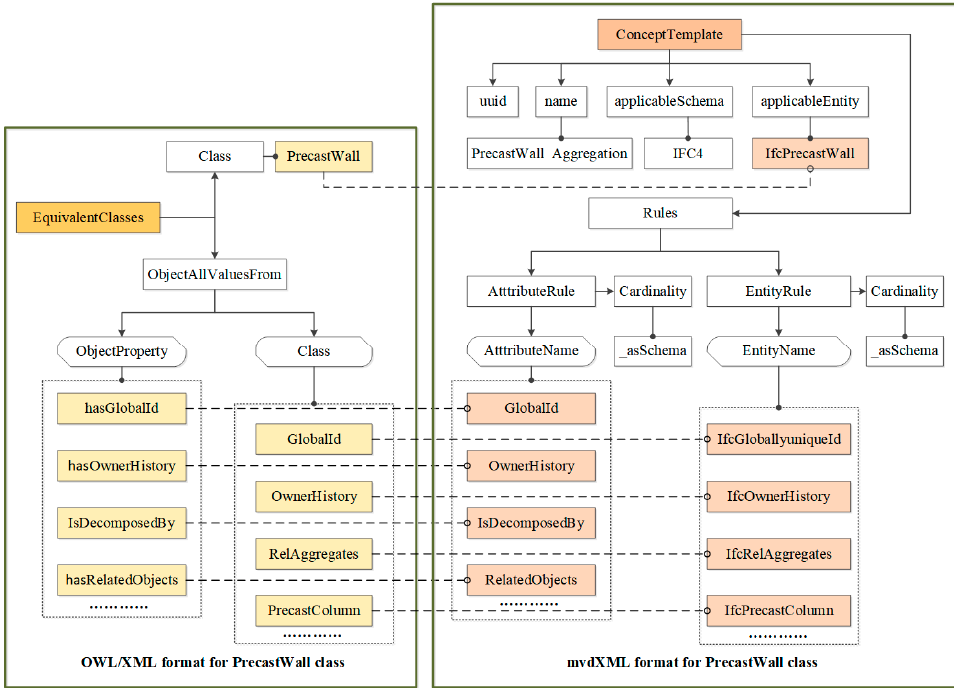
Figure 15. Data mapping between OWL/XML and mvdXML of prefabricated wall class aggregation relationship.